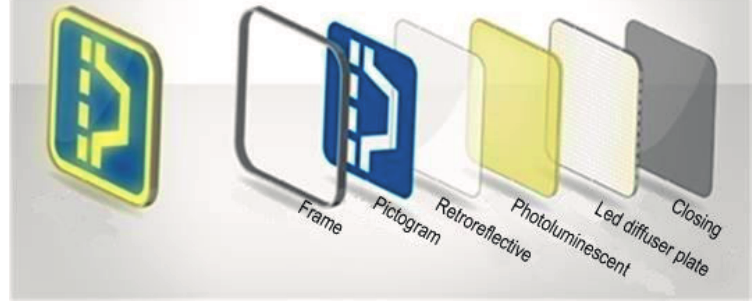
Figure 5. Signal layers scheme: pictogram, retro-reflective, photo-luminescent, and LED layers.